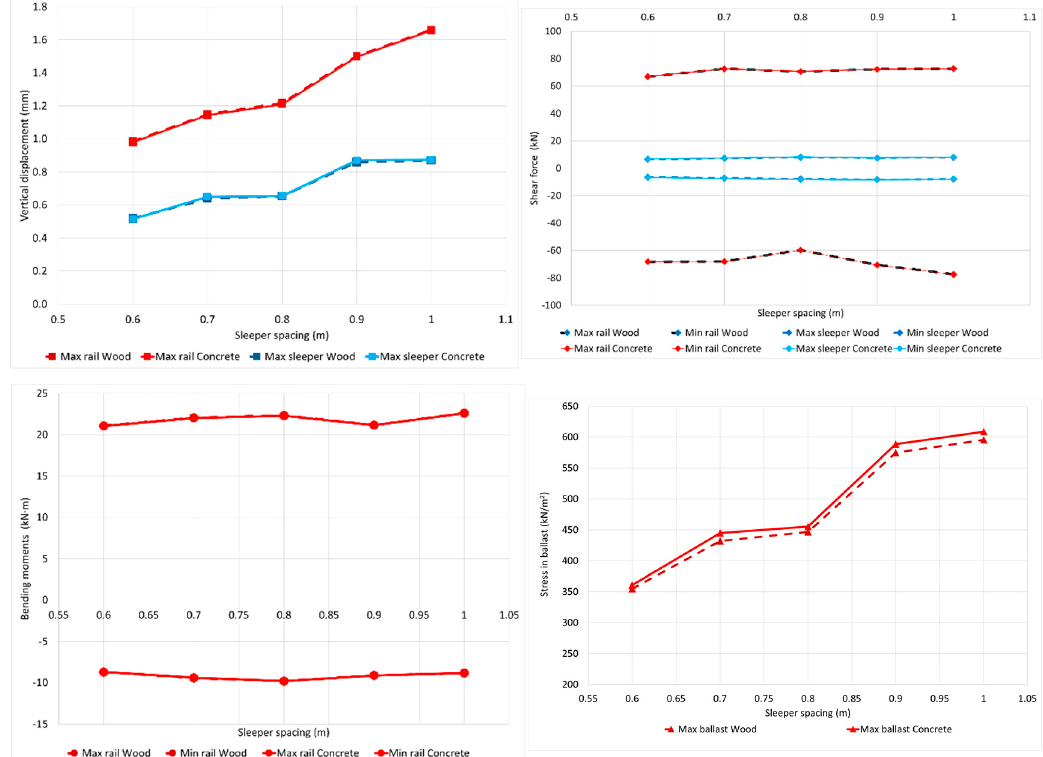
Figure 6. Case 4. Maximum vertical displacements of the rail and sleeper, shear forces on rail and sleeper, rail bending moments, and stresses on ballast.